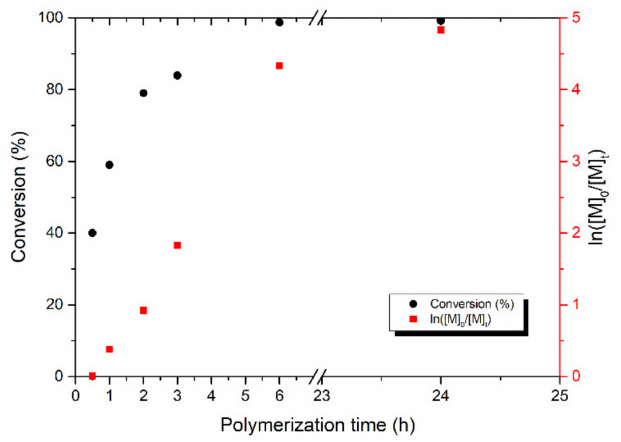
Figure 4. The time dependence of the VT conversion (circles) and first-order kinetics (squares) of 1-vinyl-1,2,4-triazole polymerization with [AIBN]:[CTA2] = 1:2 at 60 ◦ C.